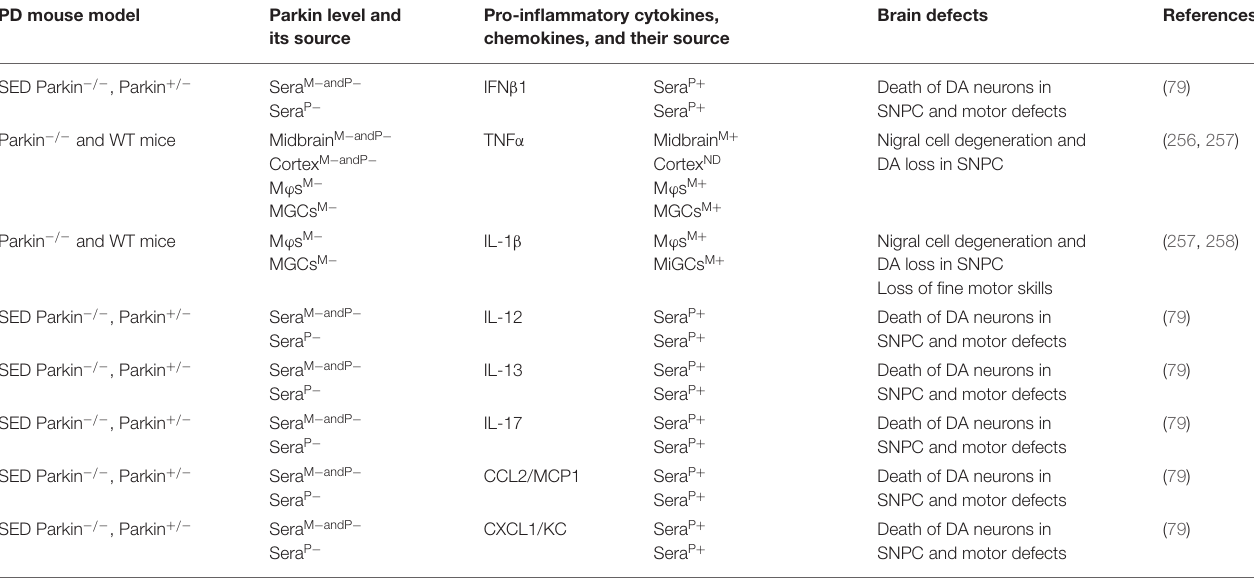
TABLE 5A | Cytokines and their source in the mouse model of PARK2 PD.